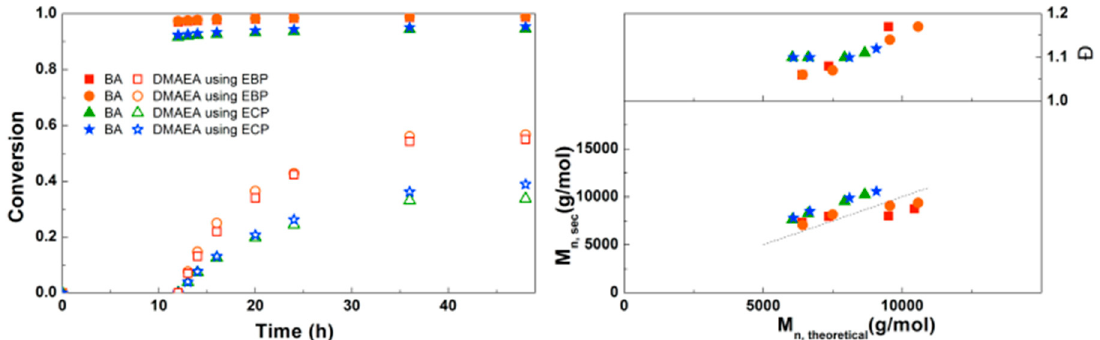
Figure 2. ( Left ): conversion versus time plot for Cu(0)-mediated one-pot block copolymerization of BA and DMAEA using [BA]:[DMAEA]:[EBP]:[Me 6 TREN]:[CuBr 2 ] = 50:50:1:0.15:0.1 and [BA]:[DMAEA]:[ECP]:[Me 6 TREN]:[CuBr 2 ] = 50:50:1:0.15:0.1, 3.0 M in DMF at 25 °C and 12.5 mm 2 /mL Cu(0) wire. A 3.0 M solution of DMAEA in DMF was added after 12 h reaction time. ( Right ): corresponding molecular weight and dispersity versus theoretical molecular weight plot.